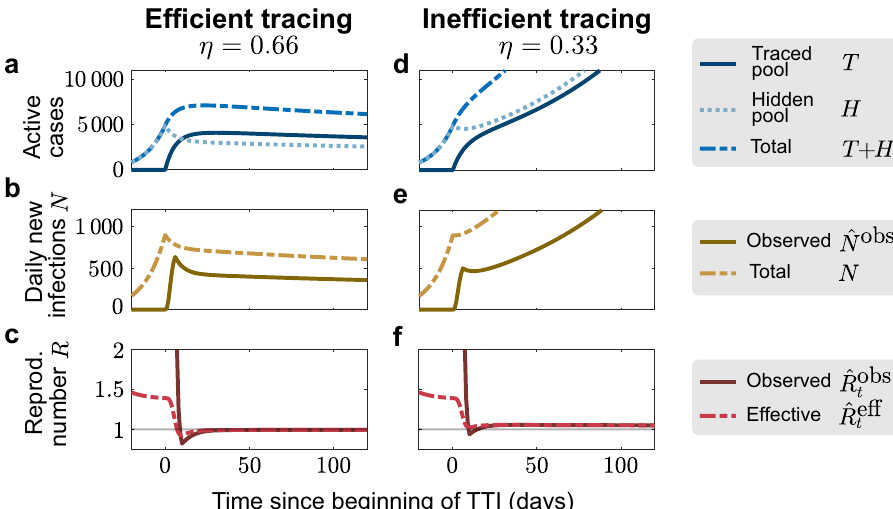
Fig. 2 Suf fi cient testing and contact tracing can control the disease spread, while insuf fi cient TTI only slows it. We consider a test-trace-and-isolate (TTI) strategy with symptom-driven testing ( λ s = 0.1) and two tracing scenarios: For high tracing ef fi ciency ( η = 0.66, a – c ), the outbreak can be controlled by TTI; for low tracing ef fi ciency ( η = 0.33, d , e ) the outbreak cannot be controlled because tracing is not ef fi cient enough. a , d The number of infections in the hidden pool grows until the outbreak is noticed on day 0, at which point symptom-driven testing ( λ s = 0.1) and contact tracing ( η ) starts. b , e The absolute number of daily infections ( N ) grows until the outbreak is noticed on day 0; the observed number of daily infections ( ^ N obs ) shown here is simulated as being inferred from the traced pool and subject to a gamma-distributed reporting delay with a median of 4 days. c , f The observed reproduction number ( ^ R obs t ) is estimated from the observed new infections ( ^ N obs ), while the effective reproductive number ( ^ R eff t ) is estimated from the total daily new infections ( N ). After an initial growth period, it settles to ^ R obs t ¼ 1 if the outbreak is controlled (ef fi cient tracing), or to ^ R obs t > 1 if the outbreak continues to spread (inef fi cient tracing). All the curves plotted are obtained from numerical integration of Eqs. (1) –